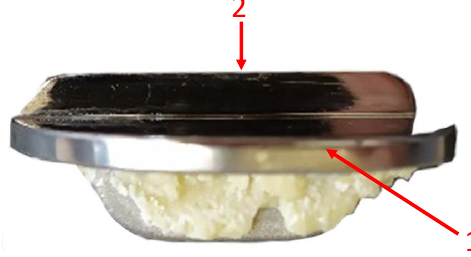
Figure 13. Samples for microstructure examinations.